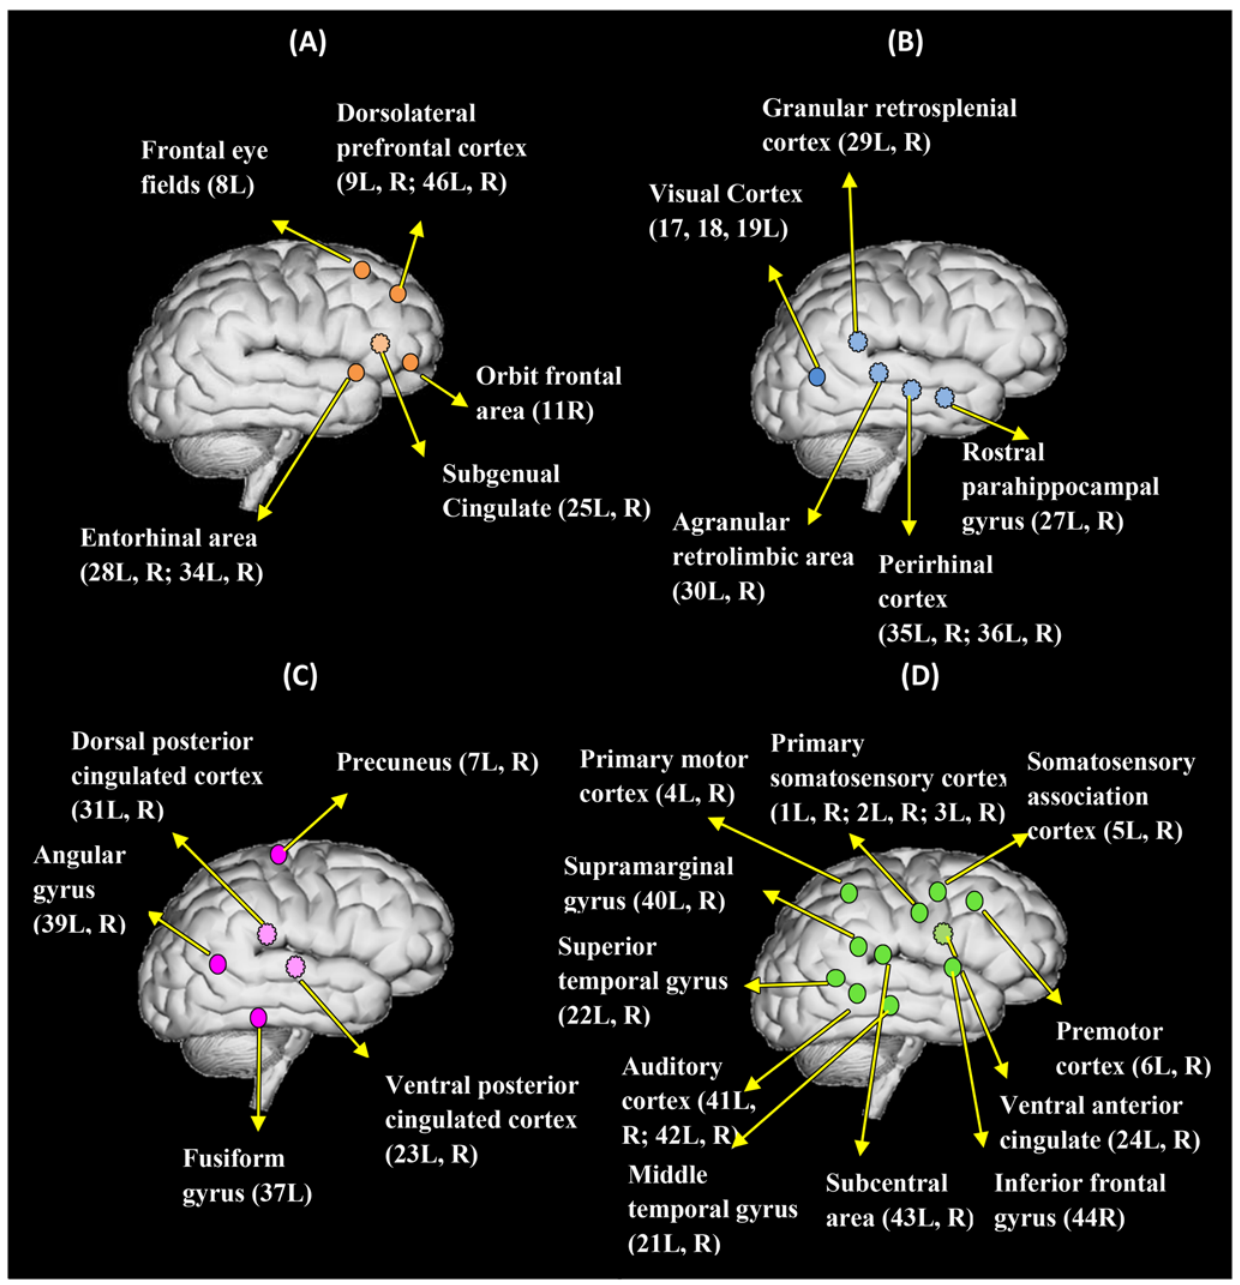
Figure 6. The four common sub-networks (functional clusters) for the NE-IL and the NE-IT conditions. (A)-(D) are hypothetical networks for executing higher-order function, comprehension/memory processing, and speech perception, respectively. The dotted circle indicates a medial surface source, while the solid circle indicates a lateral surface source. The label for each anatomical region includes the Brodmann area name and the laterality information.